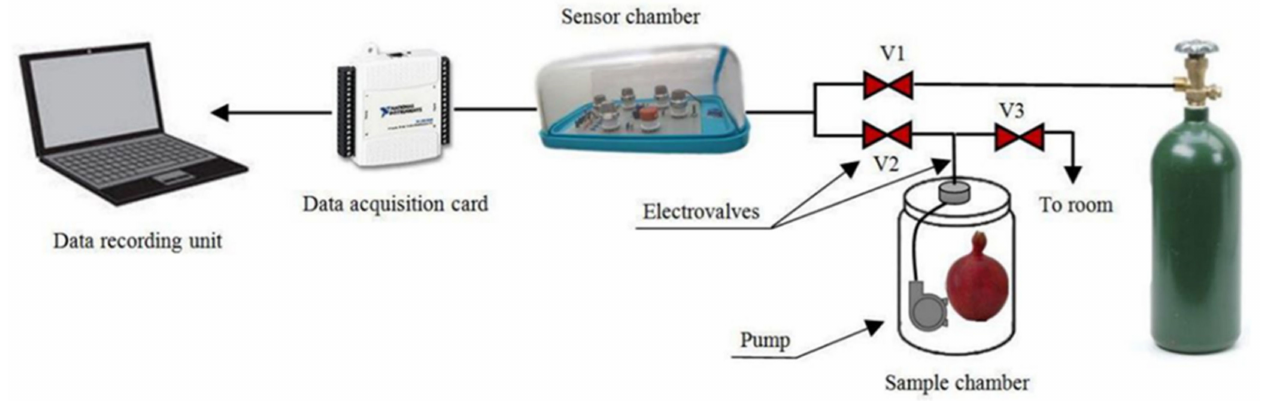
Figure 8. Illustration of a typical data acquisition setup for an e-nose system application. Adapted from [102]. V1-V3 represent electrovalves as clearly shown by arrow to